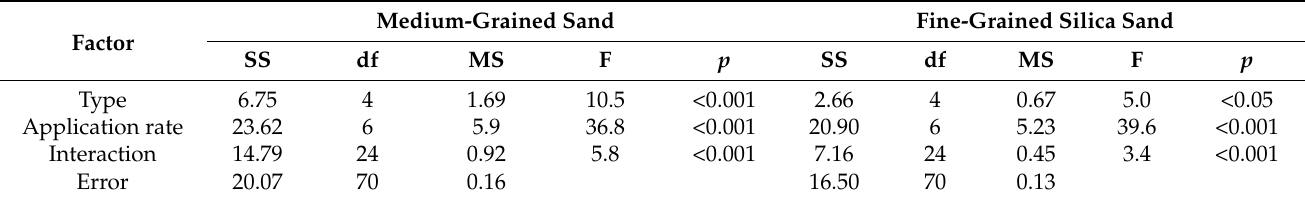
Table 6. Results of two-way ANOVA ( α = 0.05) of penetration resistance test data of Phase 2, investigating the effect of the application rate on the crust penetration